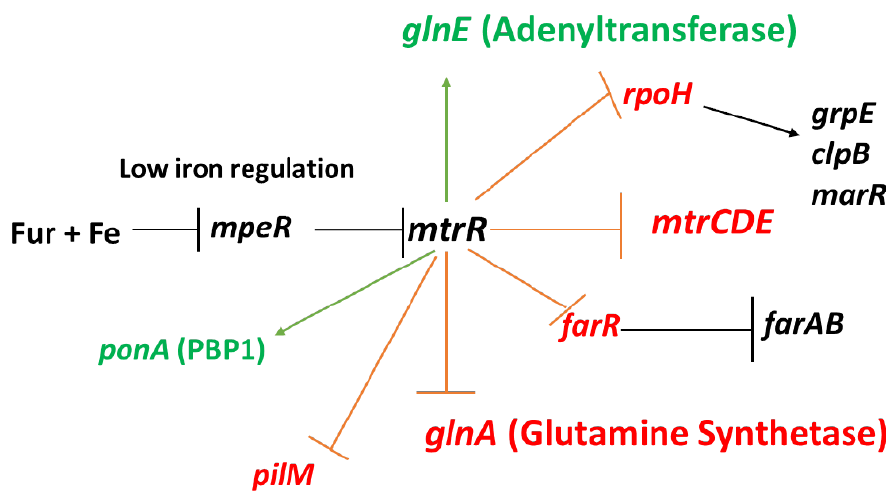
Figure 1. MtrR regulation of gonococcal genes. Shown are genes subject to direct or indirect regulation by MtrR (see text for details). Genes under negative control by MtrR are indicated by a red barred line extending from mtrR while those activated by MtrR are indicated by a green arrow extending from mtrR ; other important regulated genes are shown with black arrowed or barred lines to signify transcriptional activation or repression of expression, respectively. Repression of mtrR expression by the product of the mpeR gene which is in-turn negatively controlled by Fur + iron are also